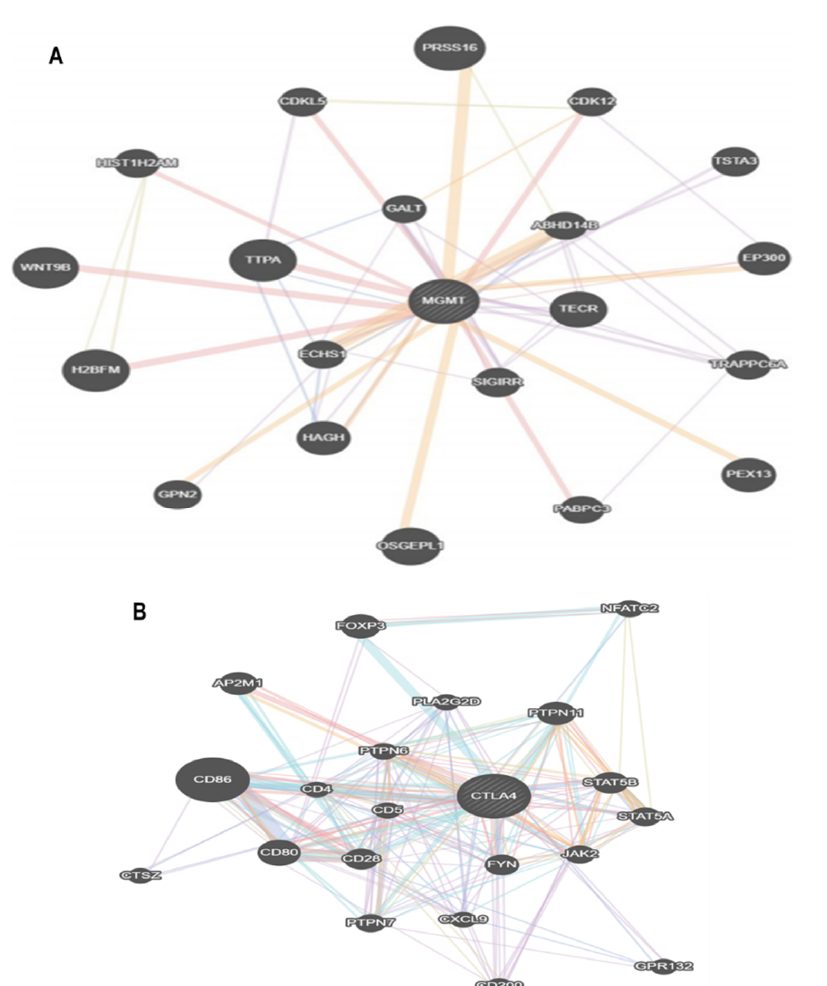
Figure 4. Genetic network showing the MGMT and CTLA4. ( A ) The gene-gene interaction network of MGMT related to GBM treatment. ( B ) The gene-gene interaction network of CTLA4. These data were derived from GeneMANIA database [121].